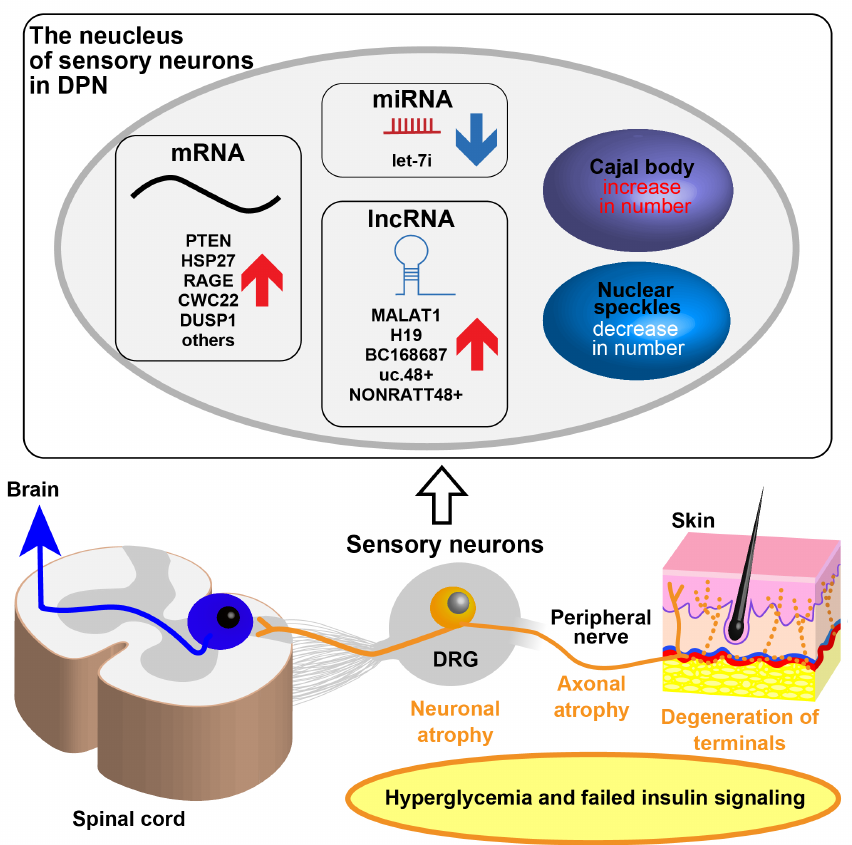
Figure 1. Schematic and simplified representation of pathogenetic mechanisms and alterations of gene expression within DRG during DPN. DPN is associated with DRG sensory neuronal atrophy and a reduced intraepidermal nerve fiber density (IENFD) due to a dying-back degeneration of distal axons. Gene expression changes in sensory neurons in DPN are accompanied by structural changes in nuclear bodies, which are essential for transcriptional activity.